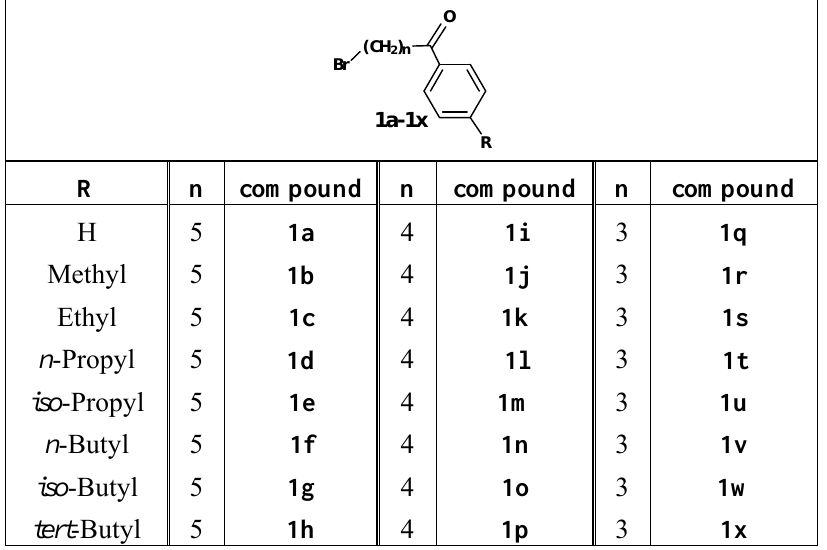
Table 1. Synthesized 1-aryl- ω -bromo ketones 1a-1x (n = 3-5; R = H; C